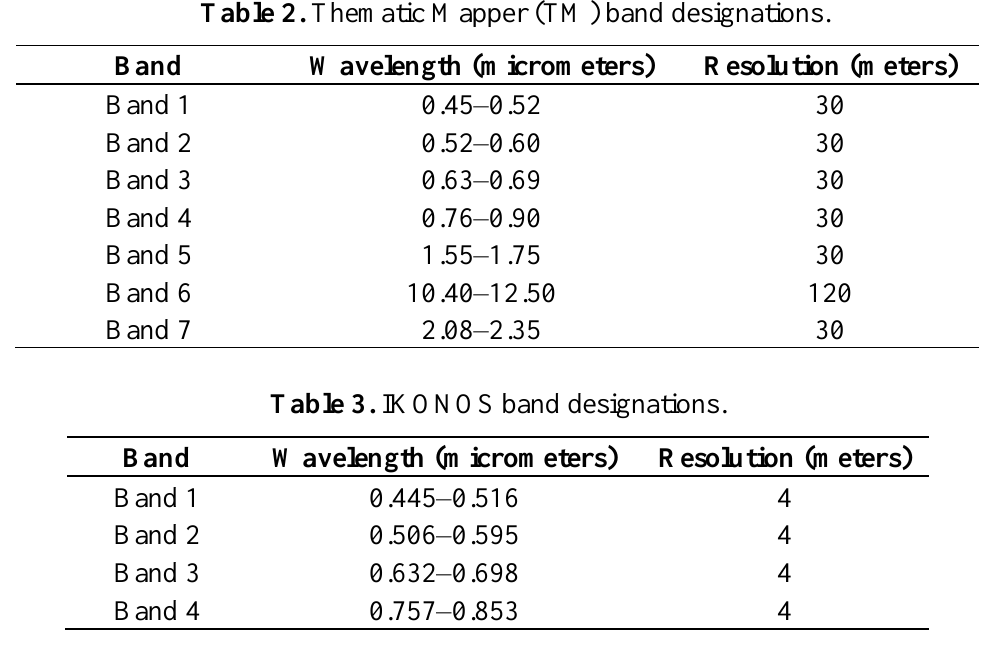
Figure 5. Multiple spectral images of IKONOS data for Guatemala study